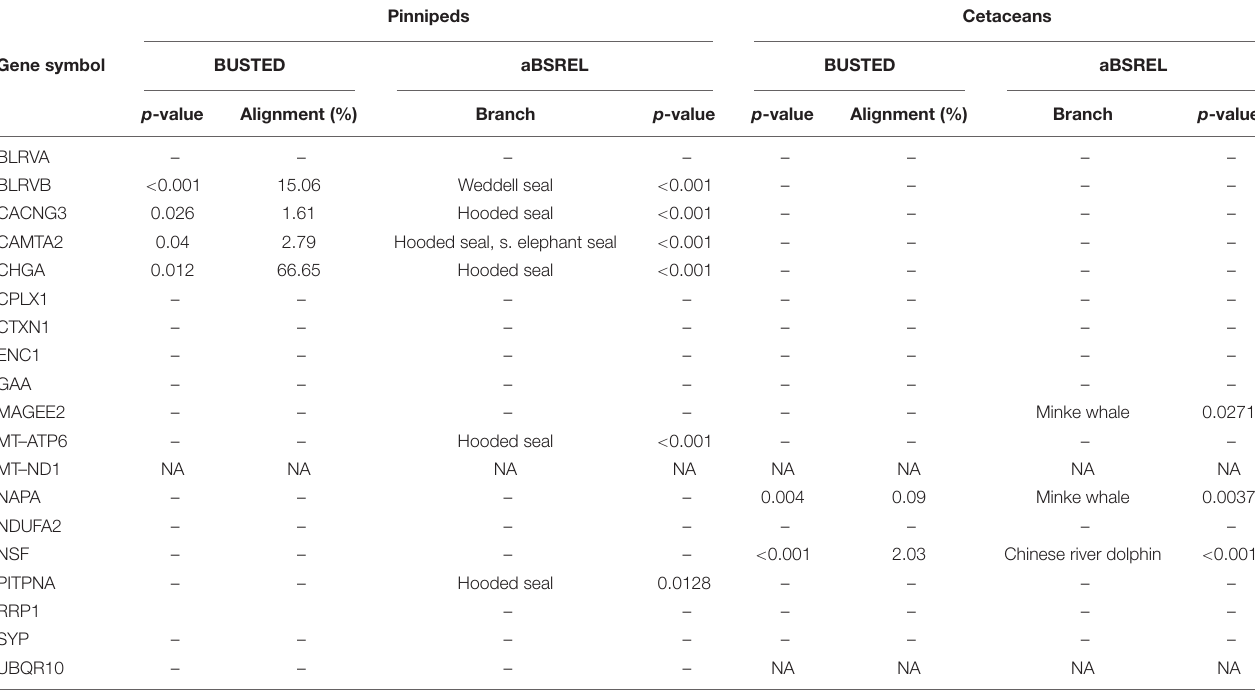
TABLE 4 | Positive selection among pinniped and cetacean lineages calculated used BUSTED and aBSREL.